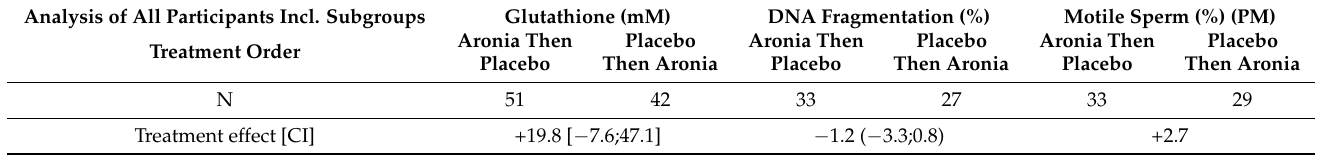
Table 2. Cytoprotective effects of Aronia supplementation measured on glutathione levels in blood serum, sperm DNA fragmentation, and percentage of motile sperm. Upper part of the table list data on the entire group of men. The lower part of the table illustrates the statistical analysis of subgroups defined according to age, BMI, dietary habits, and level of daily activity. [CI] = Confidence interval. Analysis of All Participants Incl.